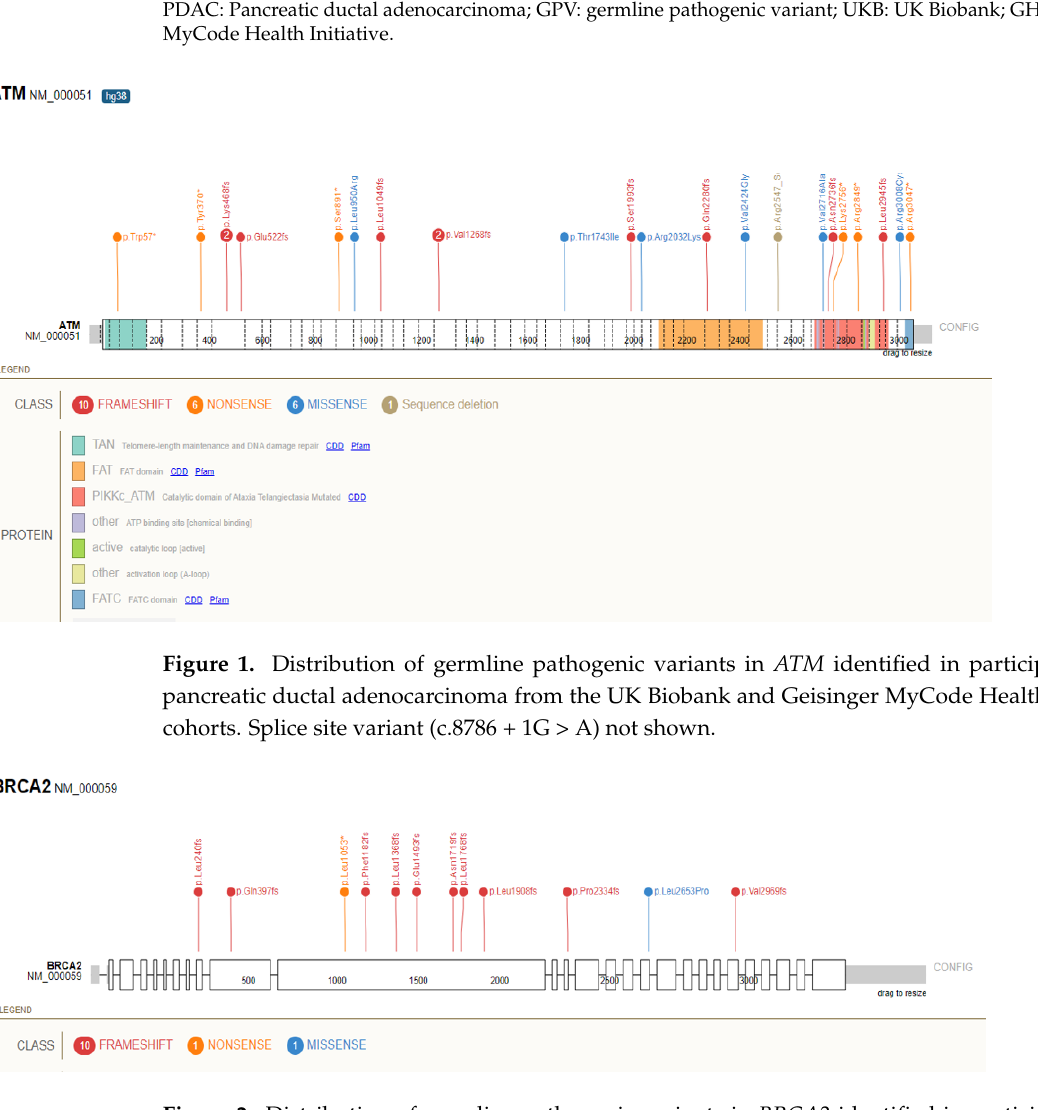
Figure 2. Distribution of germline pathogenic variants in BRCA2 identified in participants with pancreatic ductal adenocarcinoma from the UK Biobank and Geisinger MyCode Health Initiative cohorts. Splice site variants (c.7977-1G > C and c.8487 + 1G > C) not shown.